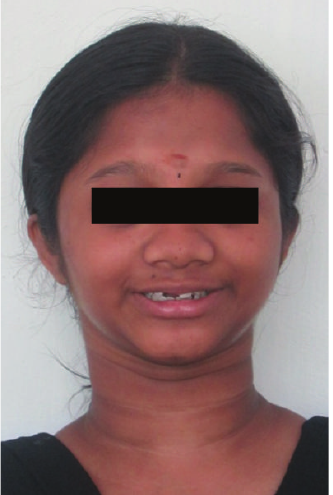
Figure 2: Patient and her mother of similar height.